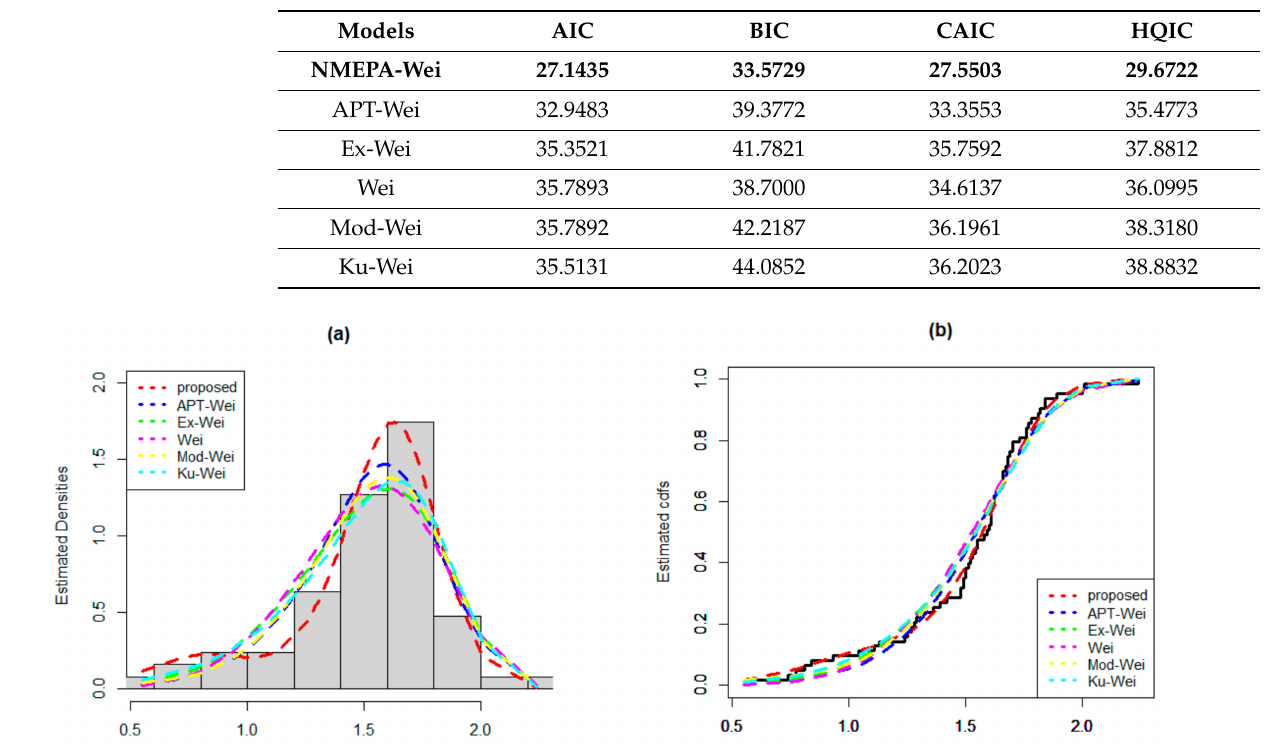
Table 5. The discrimination AIC, BIC, CAIC, and HQIC measures of competitive models using glass fiber data set (Data 1).